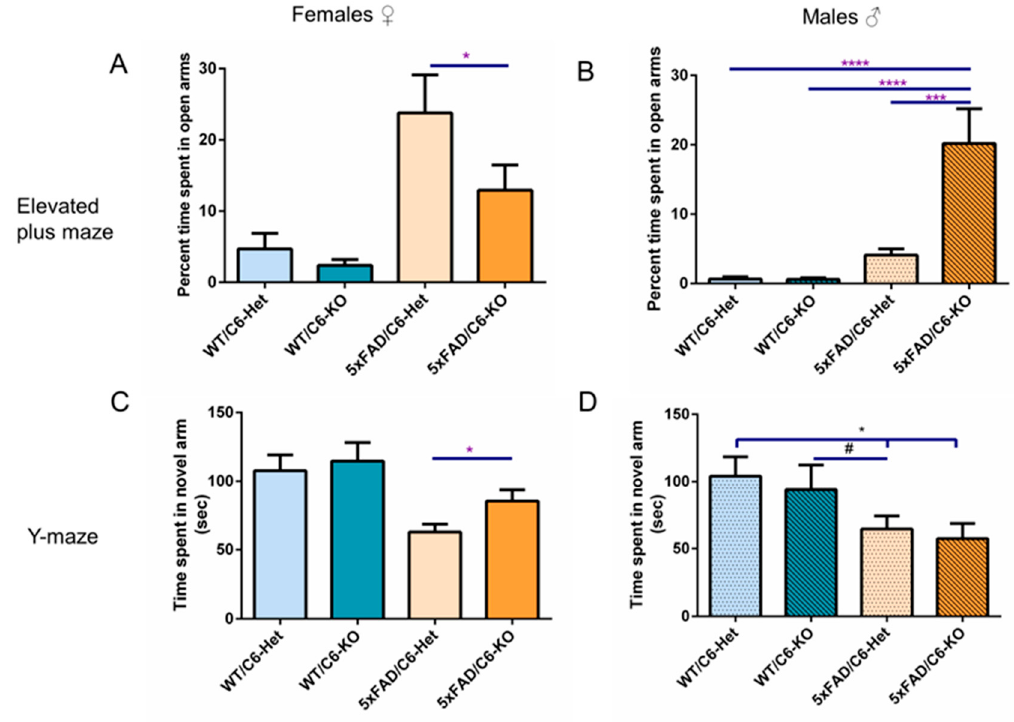
Figure 1. Behavioral amelioration in 5xFAD/C6-KO female mice in the Y-maze and elevated plus